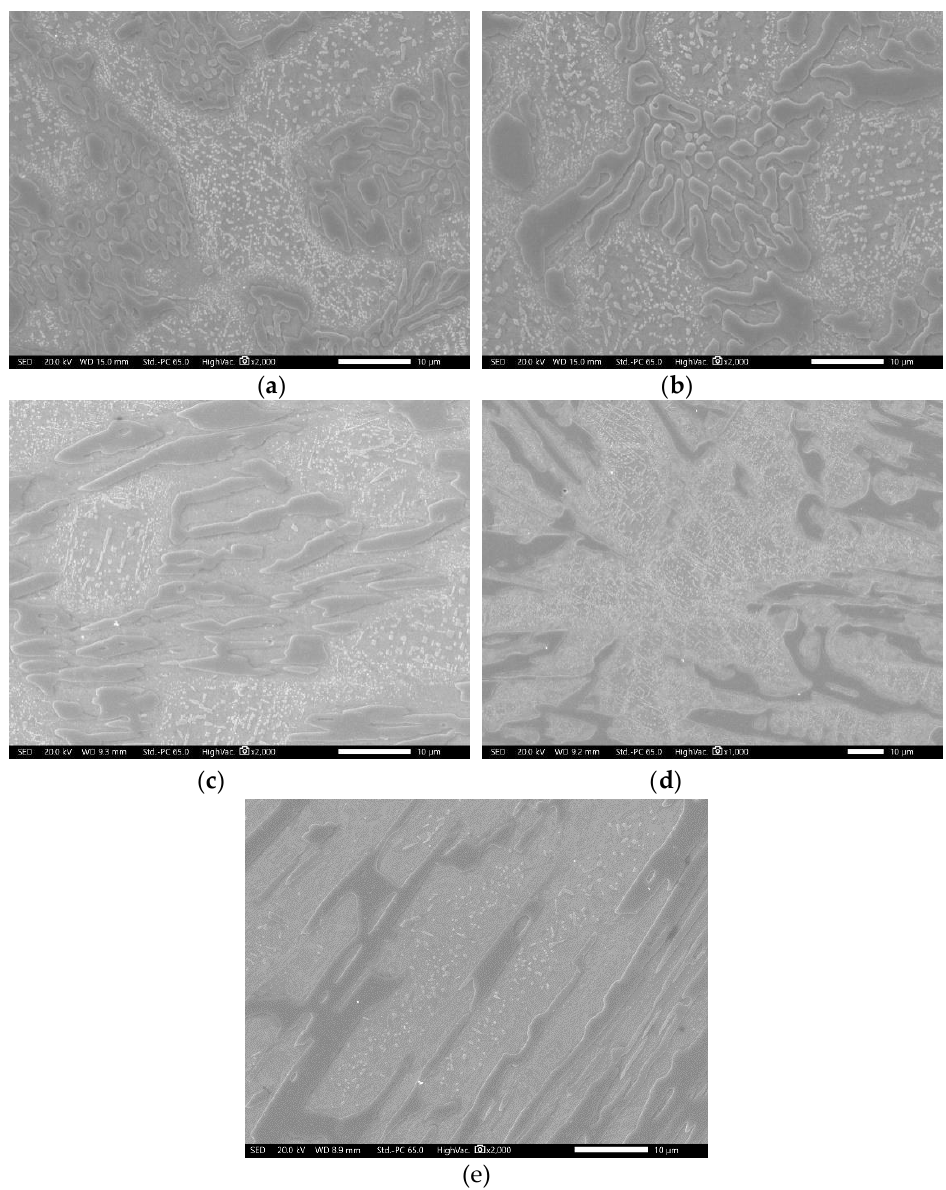
Figure 9. Micrographs of DES + WQ + Temp-treated alloys showing similar to those in the conventionally heat-treated alloys: ( a ) 2124; ( b ) 2127; ( c ) 2427; ( d ) 2827; ( e ) 2927.